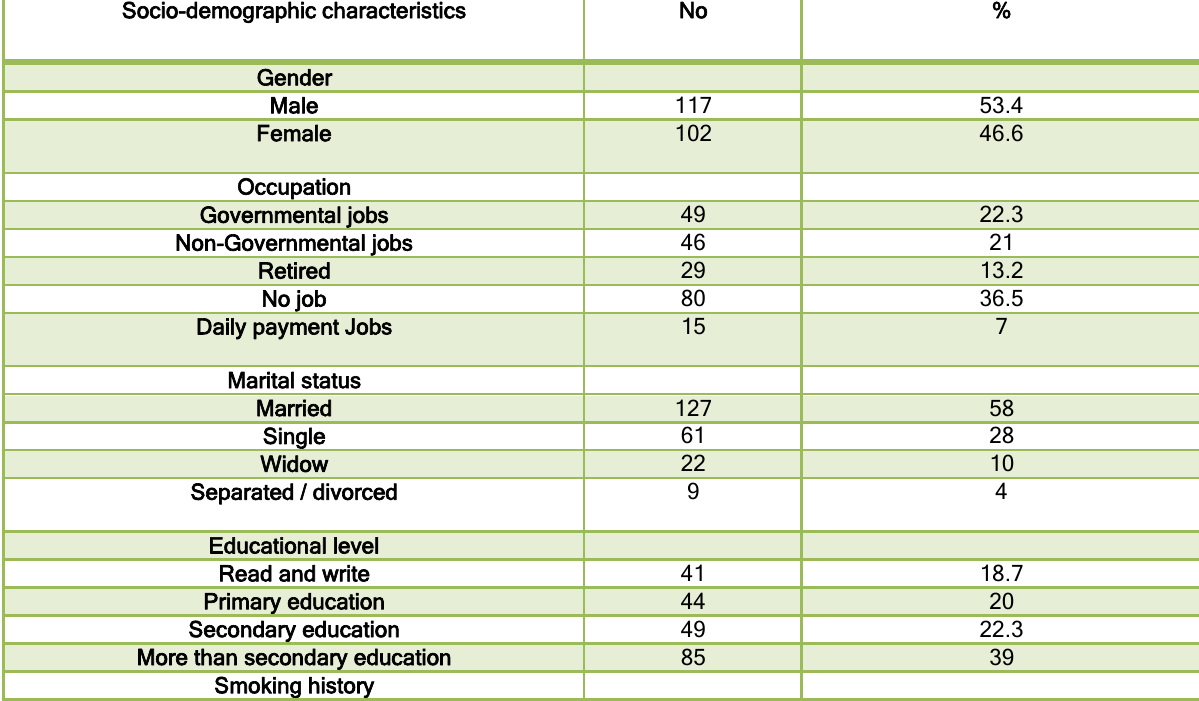
Table (1): Distribution of the studied sample regarding socio-demographic characteristics.(N=219) Socio-demographic